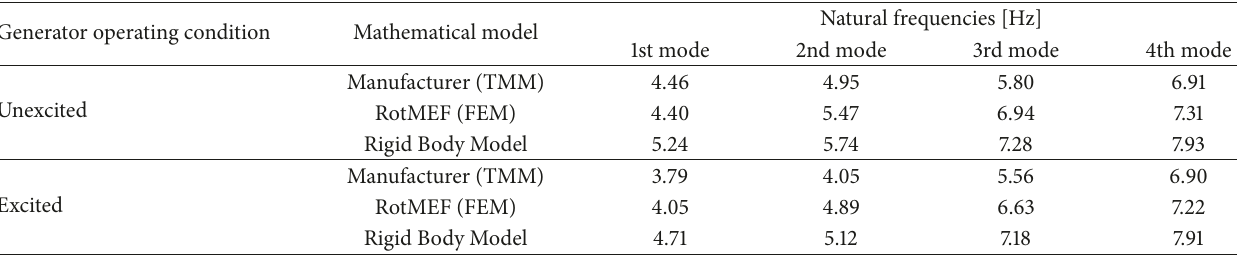
Table 4: Comparison of the natural frequencies of Itaipu LHG obtained by the manufacturer Transfer Matrix Method (TMM), using the software RotMEF and using the Rigid Body Model, with the generator unexcited and